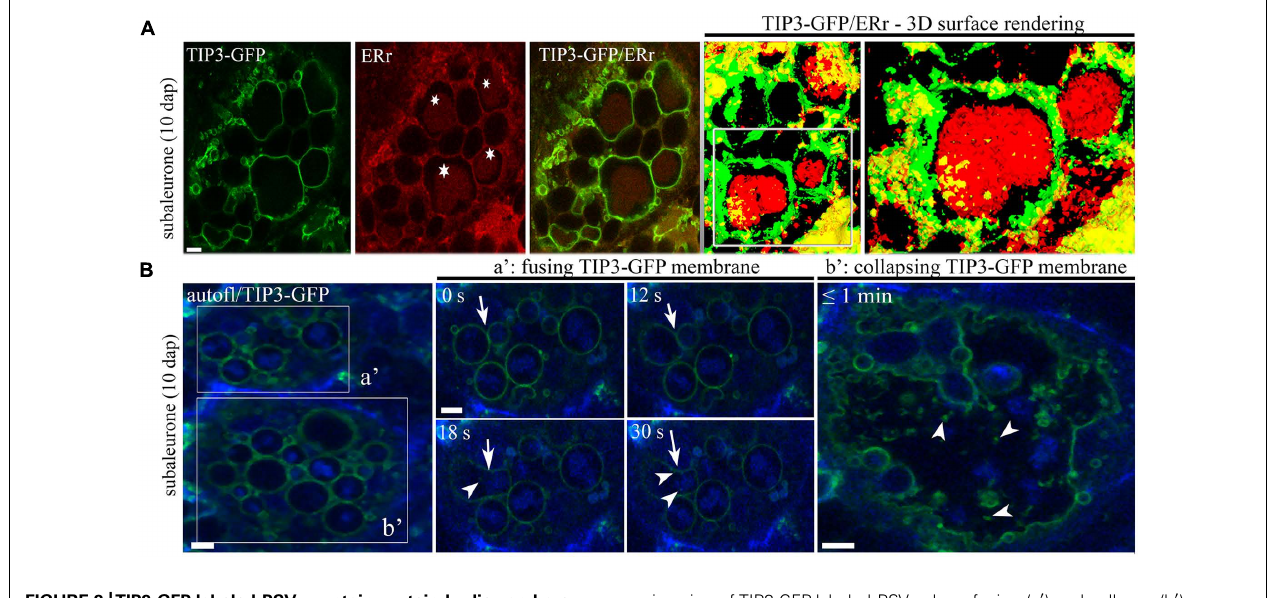
FIGURE 2 |TIP3-GFP-labeled PSVs contain protein bodies and are involved in fusion and rupture in barley endosperm. (A) TIP3- GFP-labeled PSVs comprise large protein bodies stained with ER-Tracker TM red (asterisks). Note the three-dimensional surface rendering (and the magnified inset) of 16 sections with a step size of 0.5 μ m. (B) Live cell